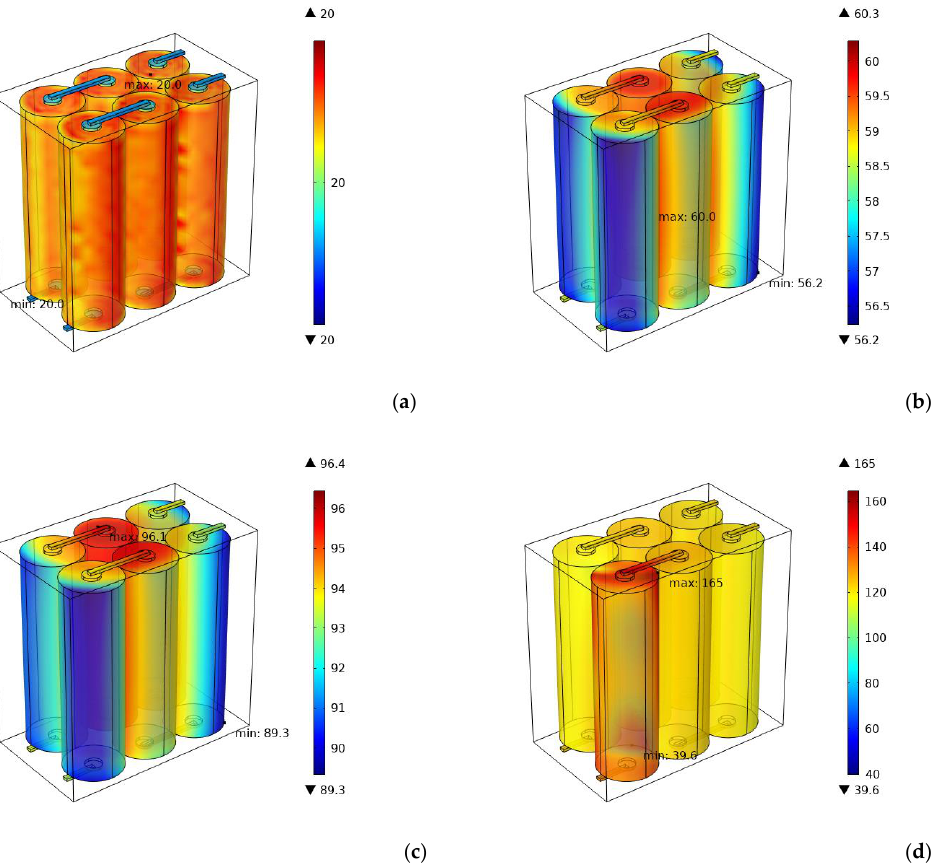
Figure 10. Temperature distribution inside the battery pack as a result of the decomposition reactions: ( a ) instant t = 0; ( b ) t = 500 s; ( c ) t = 1000 s and ( d ) t = 1500